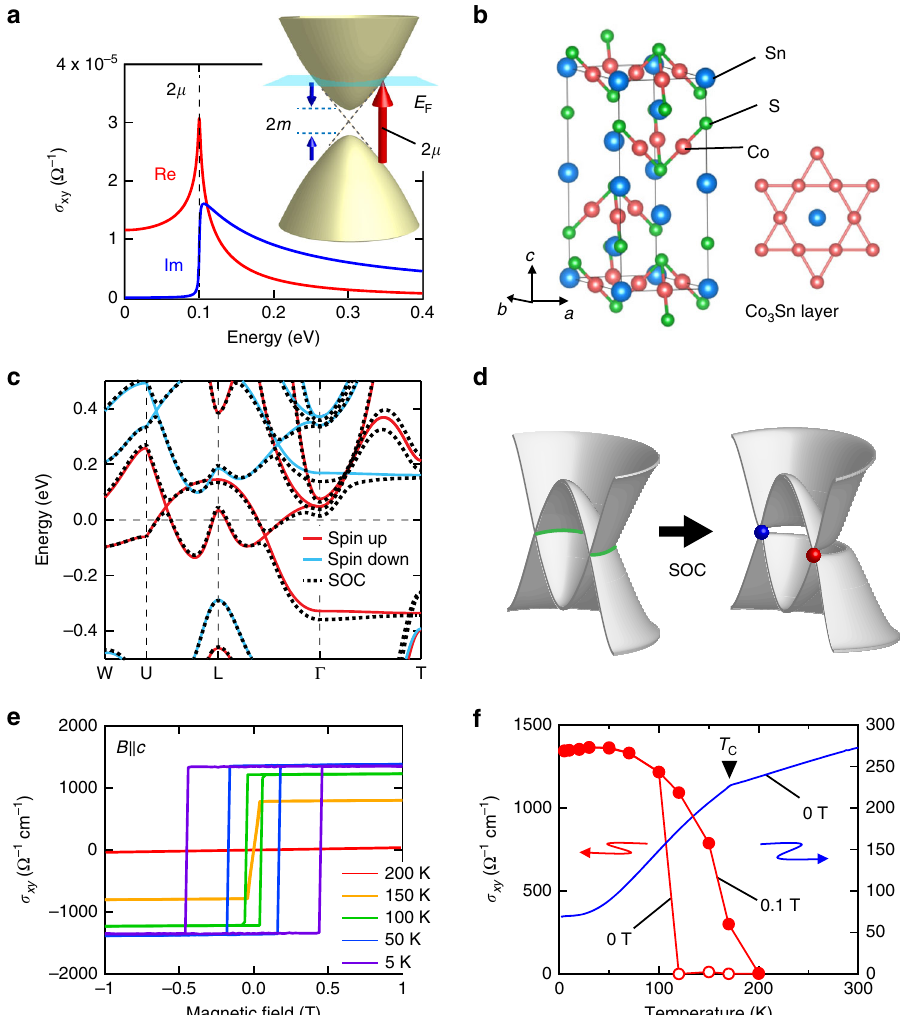
Fig. 1 Electronic structure and anomalous Hall effect (AHE) of magnetic Weyl semimetal Co 3 Sn 2 S 2 . a Optical Hall conductivity σ xy ( ω ) calculated for a single anti-crossing point in the two-dimensional electronic structure with mass gap m = 0.03 eV and chemical potential μ = 0.05 eV. The red and blue curves are the real and imaginary parts of σ xy ( ω ), respectively. The inset shows the schematics of the band structure assumed in this calculation. b The crystal structure of Co 3 Sn 2 S 2 and kagome network within Co 3 Sn layer. c Band structure obtained from the fi rst-principles calculation. The red and blue lines represent the spin-up and spin-down bands, respectively, without spin – orbit coupling. The dotted line represents the band structure with the spin – orbit coupling. d Schematic illustrations of the simpli fi ed band structures: nodal ring structure (left) open the gaps with the anti-crossing nodal line connected to the Weyl points (right) due to the spin – orbit coupling. e Magnetic- fi eld dependence of the Hall conductivity for each temperature when the magnetic fi eld is applied parallel to the c axis for the bulk single crystal. f Temperature dependence of Hall conductivity at 0 T (red open circles) and at 0.1 T (red fi lled circles), and resistivity at 0 T (blue line) for the bulk single structure at 0.1 eV (Fig. 2c) and the Kerr ellipticity spectra η K ( ω ) show two negative peak structures at 0.15 and 0.3 eV (Fig. 2d). The rotation angles θ F ( ω ) and θ K ( ω ) reach 160 mrad (~9.4 deg)